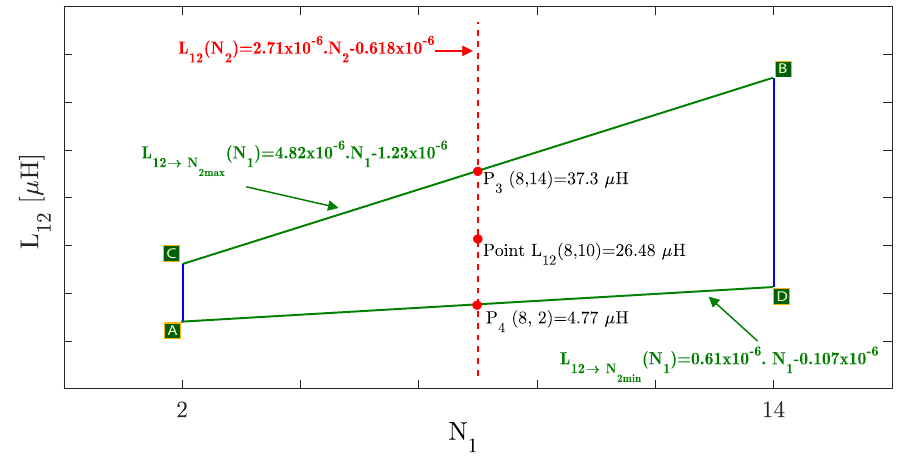
Figure 9. Profile of L 12 = f ( N 1 , N 2 ) in a 2D view for Pos 1. All admissible L 12 values for every combination of N 1 and N 2 are in between Equa- tions (15) and (16). To validate the methodology that finds L 12 for a particular set of turns, the following conditions are assumed as an example: N 1 = 8 and N 2 = 10. First, the L 12 values for points P 3 and P 4 are determined by replacing N 1 with the value 8 in (16) and (15), respectively. The impact of N 1 is already taken into account in P 3 and P 4 for N 2 max and N 2 min , respectively. The linear function between P 3 and P 4 infers the impact of N 2 in L 12 , defined as: